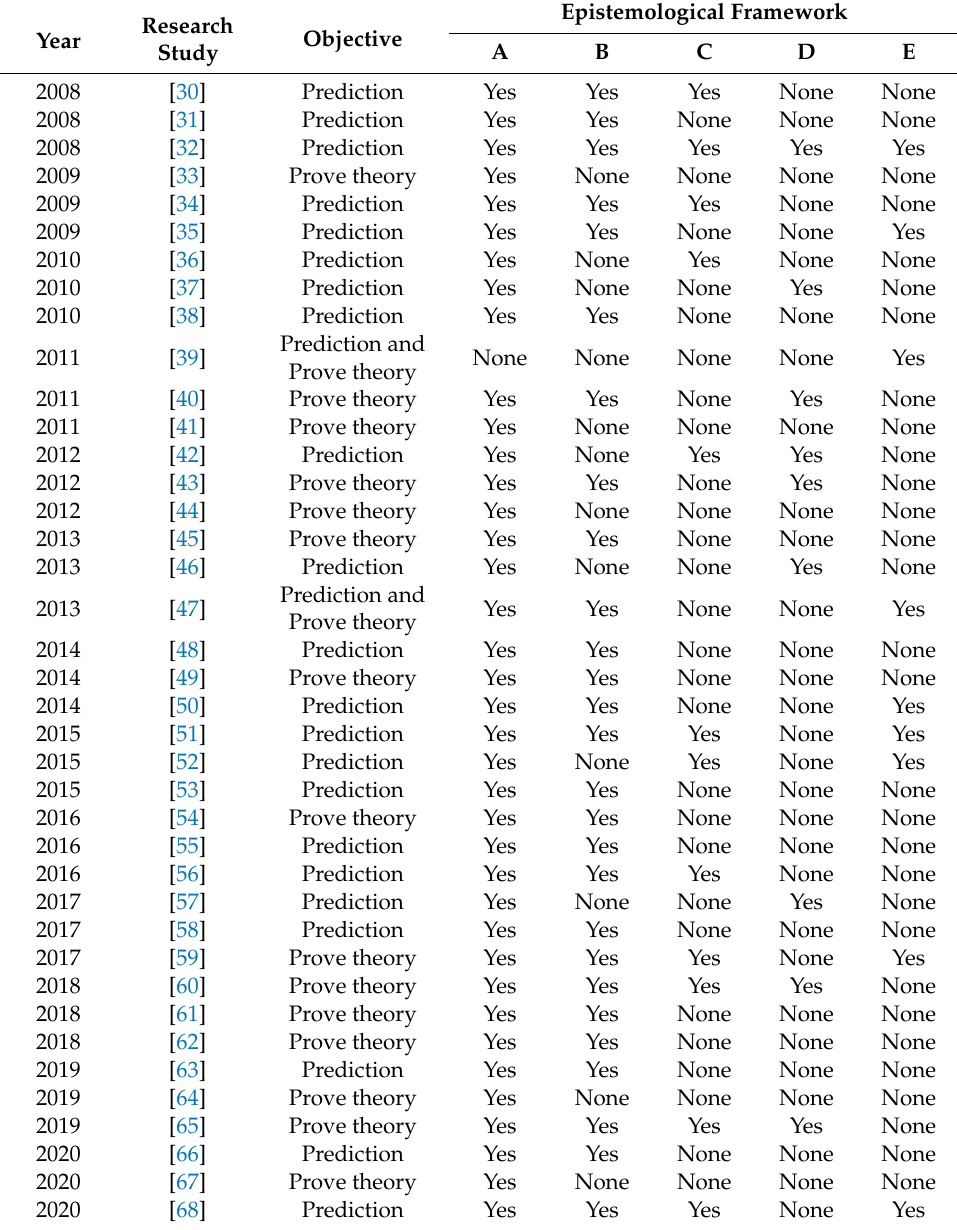
Table 2. Epistemological Framework in Simulation-Based Research